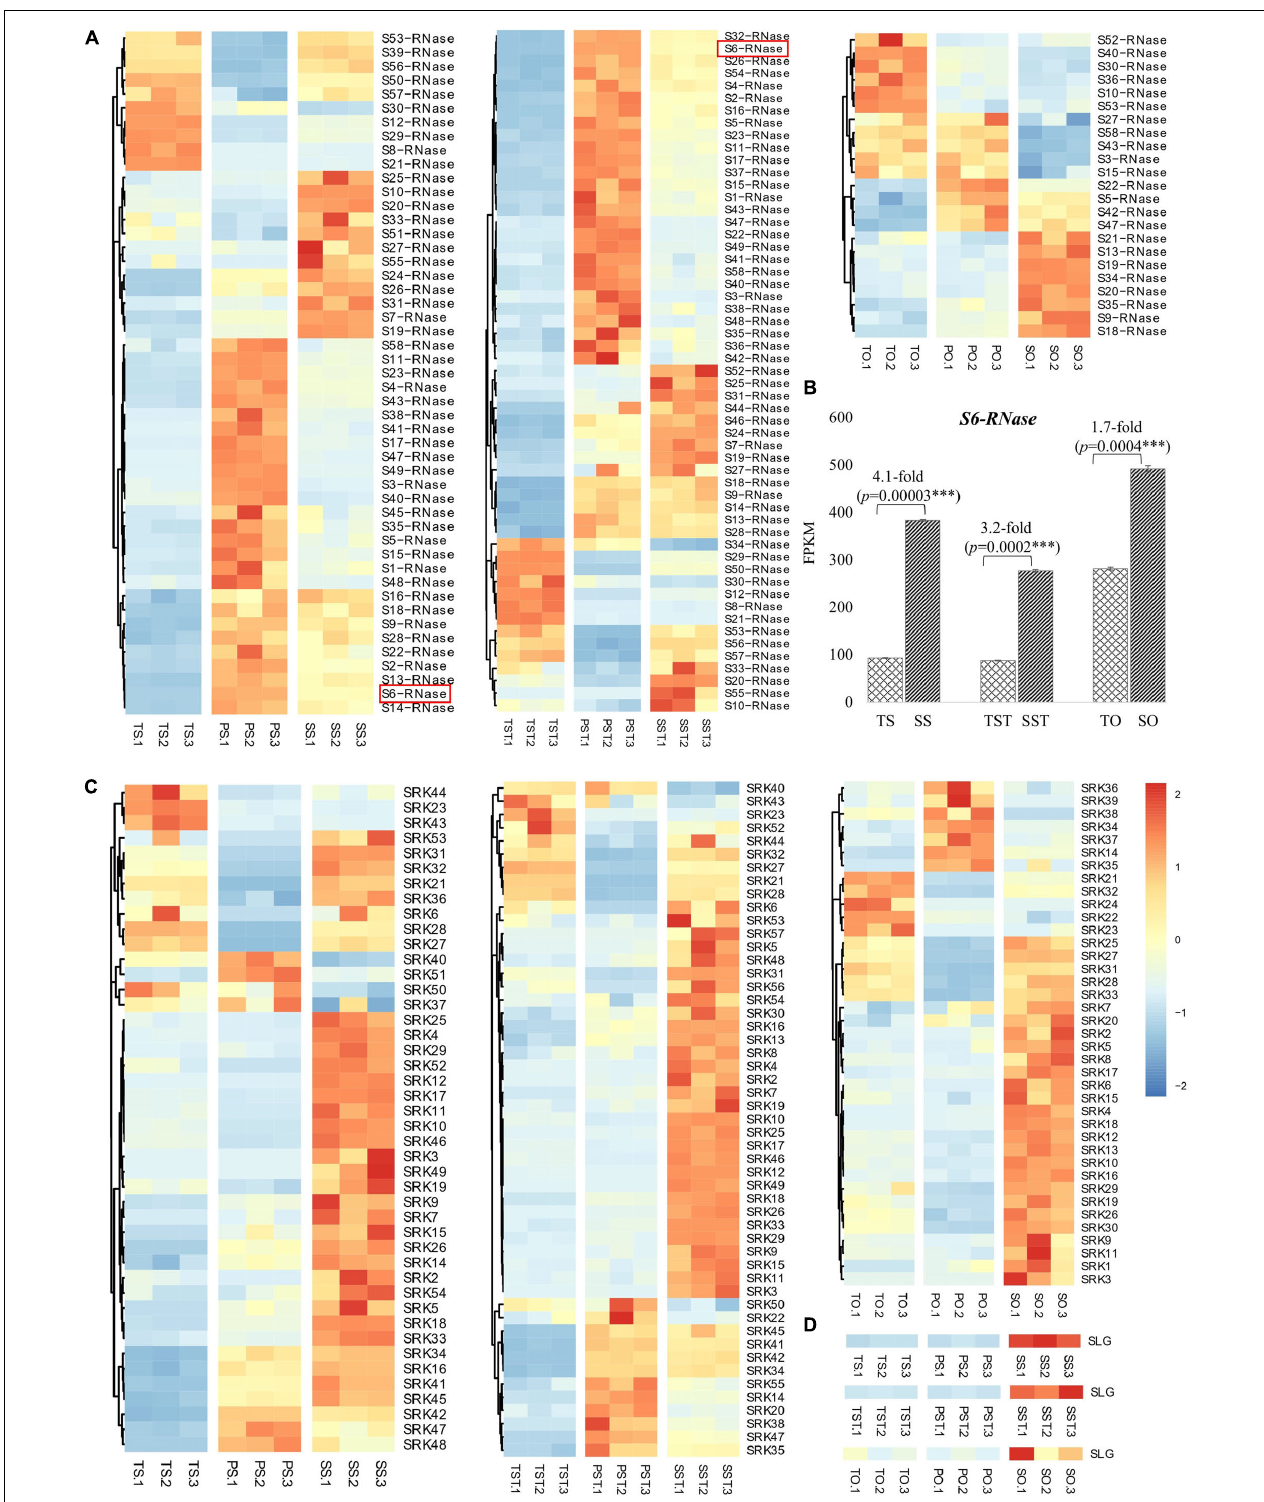
FIGURE 6 | Expression changes of S-locus genes in floral tissues of Seedless palm trees compared with Tenera and Pisifera. T, Tenera; P, Pisifera; S, seedless; S, stigma; ST, style; O, ovary. (A) Heatmap showing the expressions patterns of S-RNases. (B) Expression changes of S6-RNase which increased greater than threefold in stigma (S) and style (ST) of Seedless palm trees compared with Tenera. (C) Heatmap showing the expressions patterns of SRK genes. (D) Heatmap showing the expressions patterns of SLG gene.